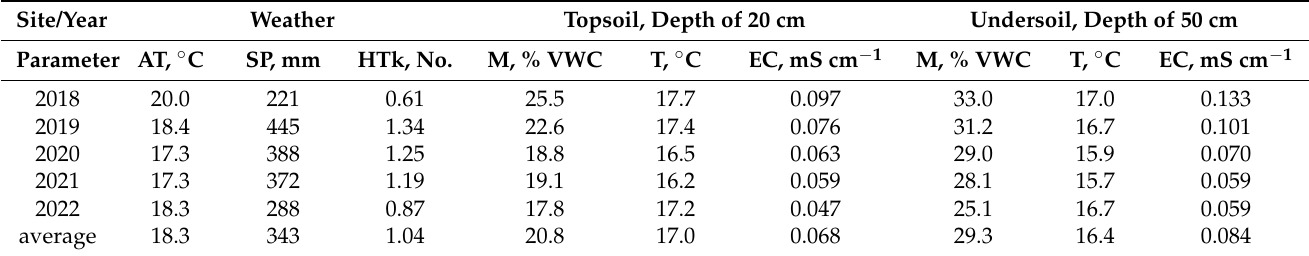
Table 4. Data concerning weather and soil conditions during the main vegetation period from April to